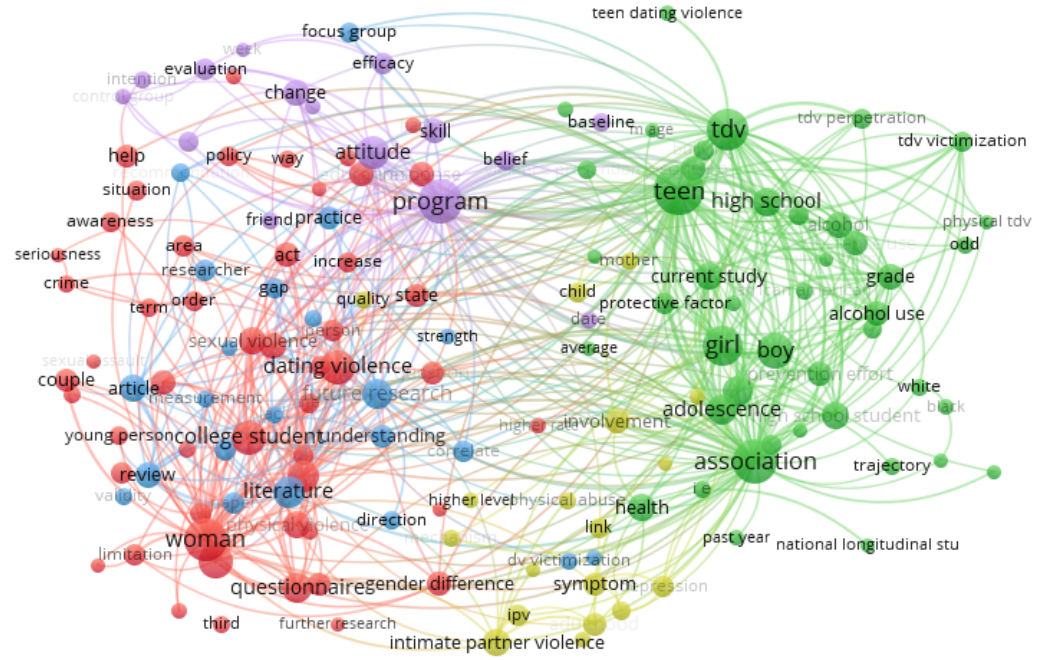
Figure 9. General analysis of co-occurrences.